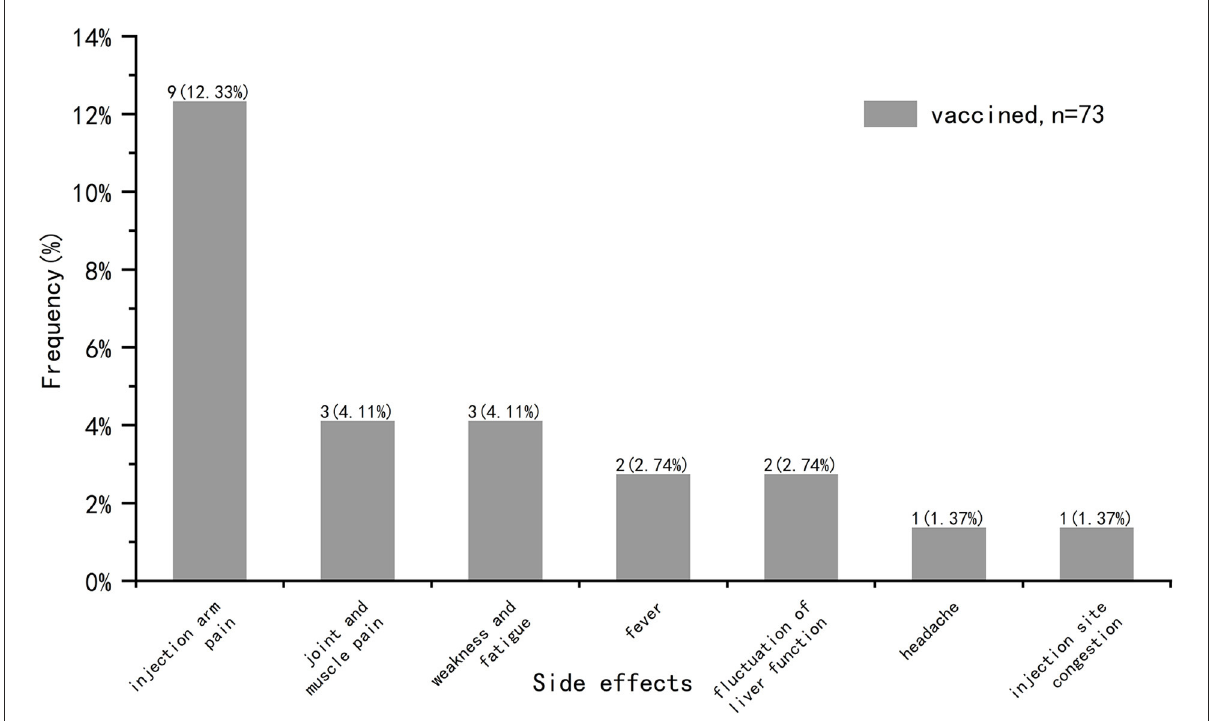
FIGURE3 COVID-19 vaccine related side effects in vaccinated participants.